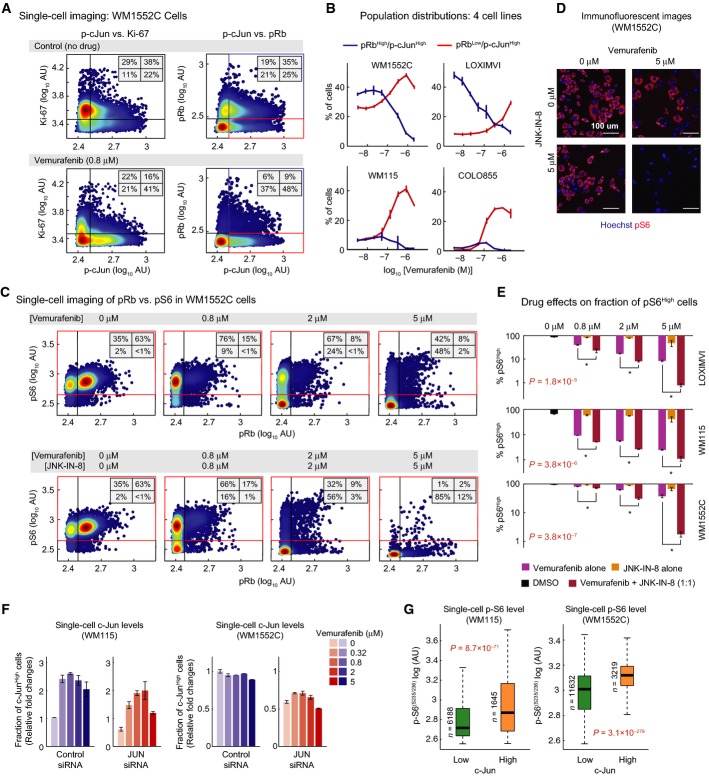
c-Jun activity up-regulation causes resistance to apoptosis in quiescent cells because of incomplete pS6 suppression

Covariate single-cell analysis of Ki-67 (left) and pRb(Ser807/811) (right) versus p-cJun(Ser73) in WM1552C cells before and 24 h after exposure to 0.8 μM vemurafenib. Density scatter plots were generated using signal intensities for individual cells as measured by immunofluorescence microscopy. The vertical lines were used to gate p-cJunHigh versus p-cJunLow cells. The horizontal lines were used to gate Ki-67High versus Ki-67Low cells, and pRbHigh versus pRbLow cells.

Analysis of drug dose-dependent changes in proportion of pRbLow/p-cJunHigh and pRbHigh/p-cJunHigh subpopulations in four melanoma cell lines (WM115, WM1552C, LOXIMVI, COLO858) after exposure to vemurafenib for 24 h. These subpopulations were gated as shown in (A). Data are represented as mean ± SD for two replicates.

Covariate single-cell analysis of pRb(Ser807/811) versus pS6(Ser235/236) following 24-h treatment of WM1552C cells with different doses of vemurafenib alone (top) and vemurafenib and JNK-IN-8 together (bottom). Drugs were added at a 1:1 ratio, each at indicated concentrations when used in combination. Density scatter plots were generated using signal intensities for individual cells as measured by immunofluorescence microscopy. The horizontal and vertical lines were used to gate pS6High versus pS6Low cells, and pRbHigh versus pRbLow cells, respectively.

Selected immunofluorescence images of pS6(Ser235/236) and Hoechst staining in WM1552C cells in a DMSO-treated control and 24 h after exposure to 5 μM of vemurafenib, JNK-IN-8, and their combination.

Analysis of the changes in proportion of pS6High cell population in three melanoma cell lines (LOXIMVI, WM115 and WM1552C) as a function of drug concentration for single-drug vemurafenib and JNK-IN-8 treatments and their combination treatment. Drugs were added at a 1:1 ratio, each at indicated concentrations when used in combination. pS6High population of cells was gated as indicated in (C). Data are represented as mean ± SD for two replicates. Data comparison between vemurafenib treatment and vemurafenib/JNK-IN-8 combined treatment was made by using two-way analysis of variance (ANOVA).

Fraction of c-JunHigh cells (as measured by single-cell immunofluorescence microscopy) after 48 h JUN knockdown followed by 24-h treatment with vemurafenib. Fold changes are shown relative to control-treated cells. Data are presented as mean ± SD.

Single-cell pS6(Ser235/236) levels in the c-JunHigh and c-JunLow fractions of cells (as measured by single-cell multiplex immunofluorescence microscopy) after 48 h of JUN knockdown and 24-h treatment with 0.32 μM vemurafenib. Single-cell pS6 data are presented as box-and-whisker plots with median signal intensities and interquartile ranges; bars extending to 1.5×  the interquartile range are shown for each condition as a measure of variance. P-values were calculated using a two-sided nonparametric Mann–Whitney U-test.

Source data are available online for this figure.